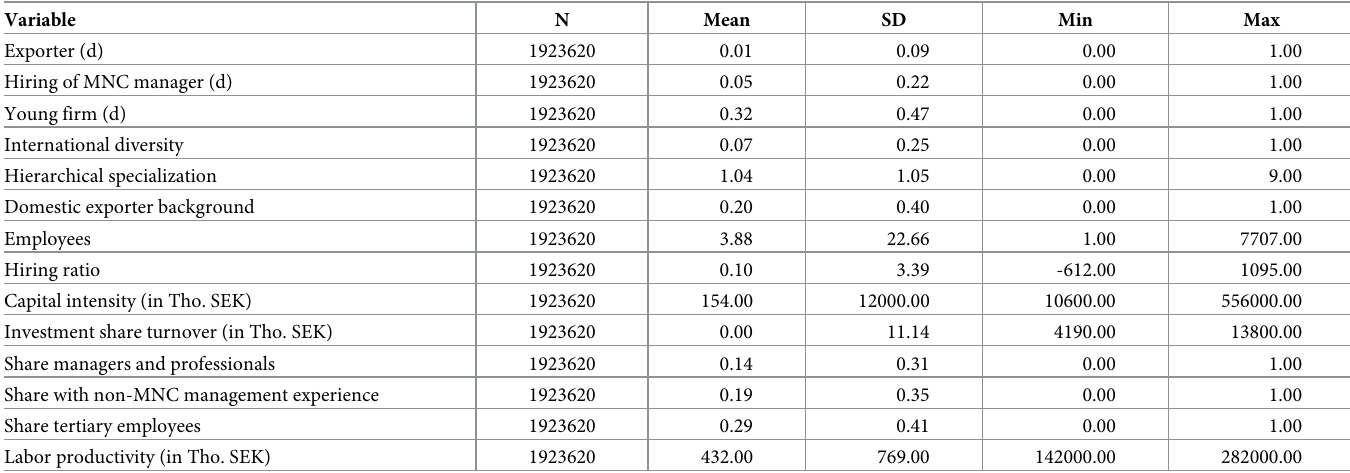
Table 1. Descriptive statistics.